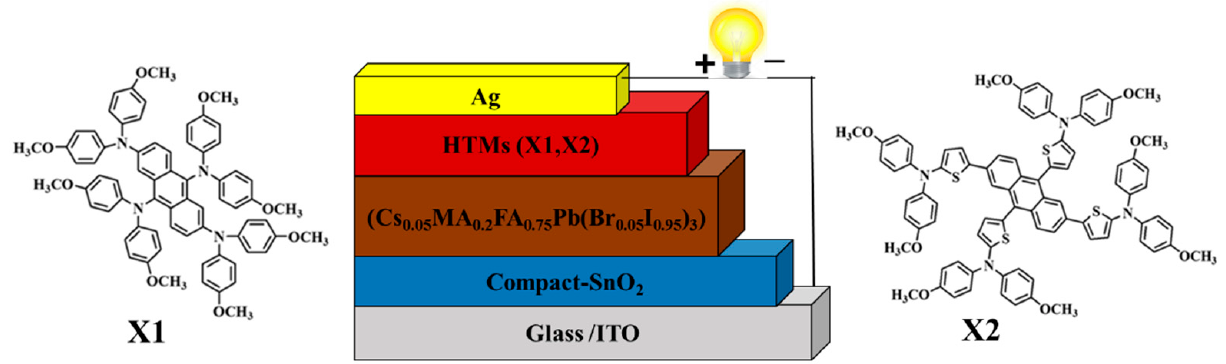
Figure 8. Device architecture ITO/compact SnO 2 /perovskite (Cs 0.05 MA 0.2 FA 0.75 Pb(Br 0.05 I 0.95 ) 3 )/HTM ( X1 , X2 )/Ag.